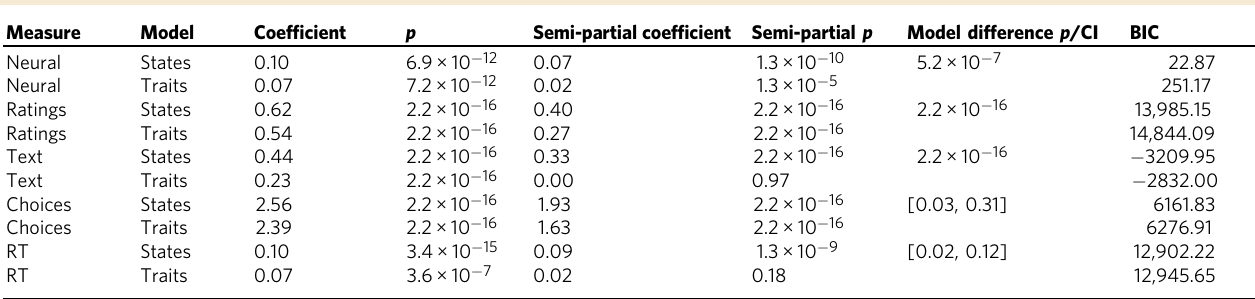
Table 1 Comparing summed states and